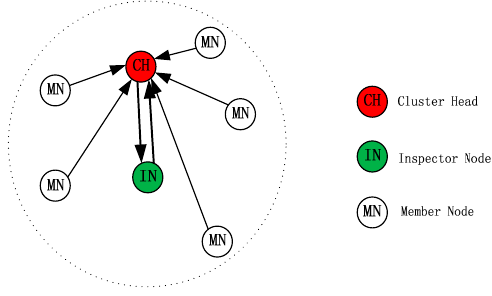
Figure 1. The basic topological structure of a cluster.